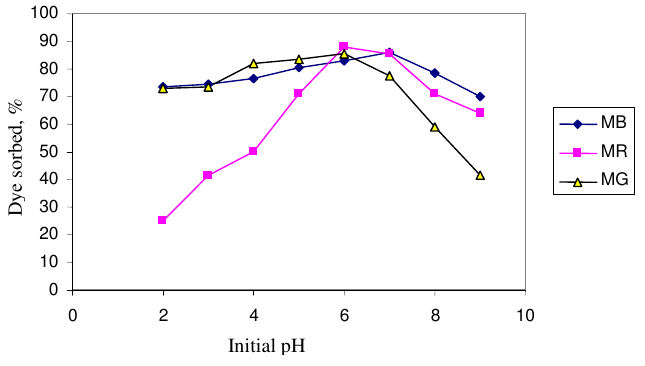
Figure 1. Influence of initial pH on biosorption of MB, MR and MG by the mixtures of leafs, fruits and twigs of Muntangia calibura (sorbent dose: 200 mg/50 mL; contact time: 3 h; dye concentration: 100